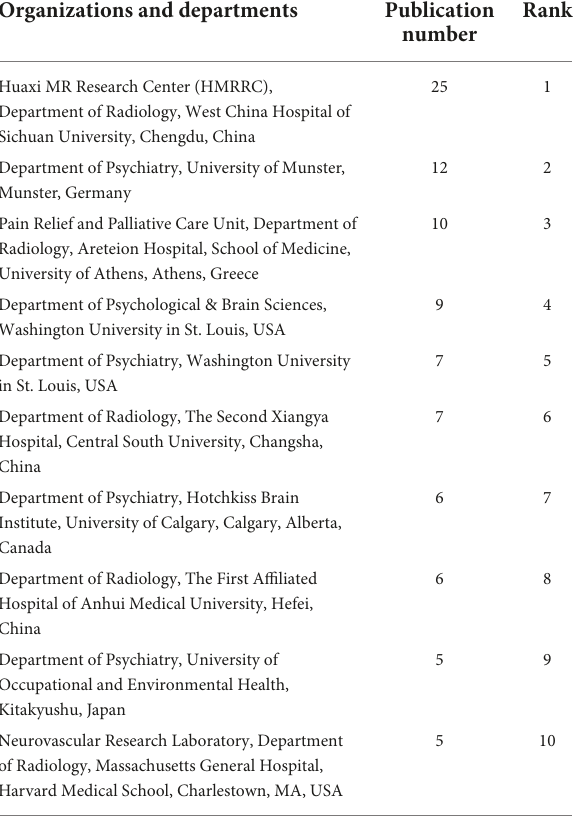
TABLE 5 Top 10 organizations with the most